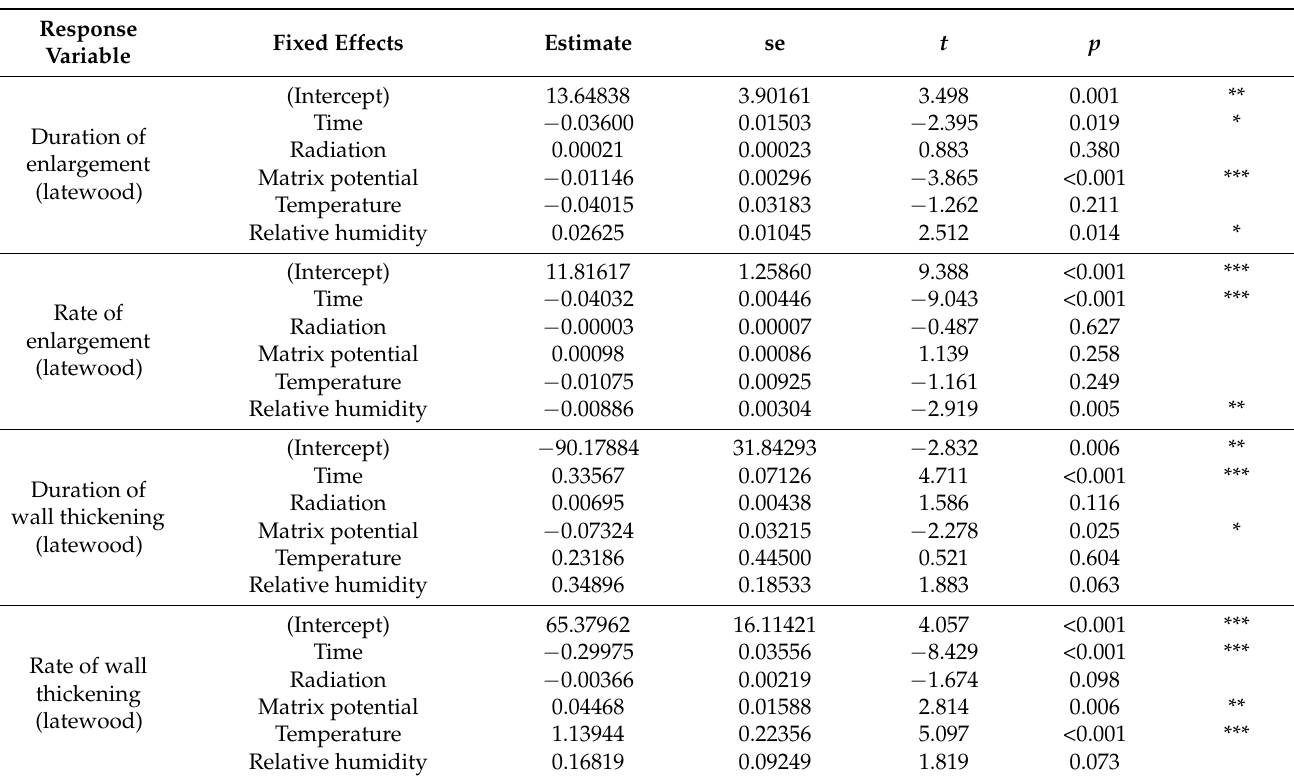
Table 3. Parameter estimates, standard errors, t -statistics, and p -values of fixed effects of linear mixed-effects models to predict the duration of cell enlargement, rate of cell enlargement, duration of cell wall thickening, and rate of cell wall thickening of latewood